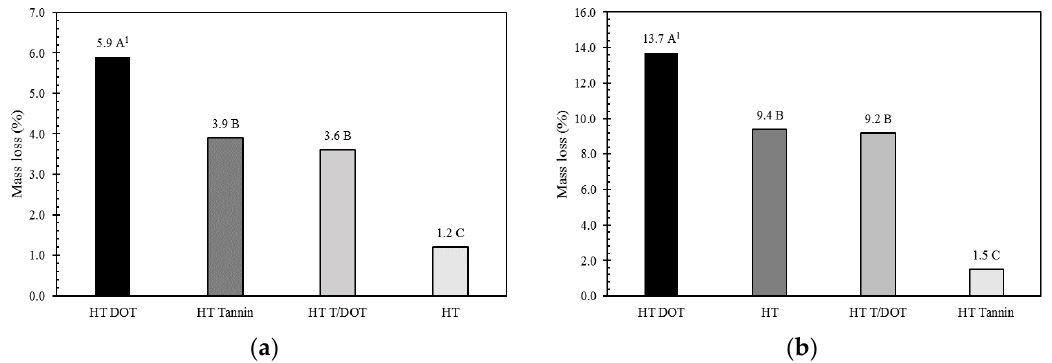
Figure 2. Mass loss due to heat treatment, ( a ) southern yellow pine and ( b ) yellow-poplar. 1 Means with the same letter are not statistically different at the 0.05 significance level.